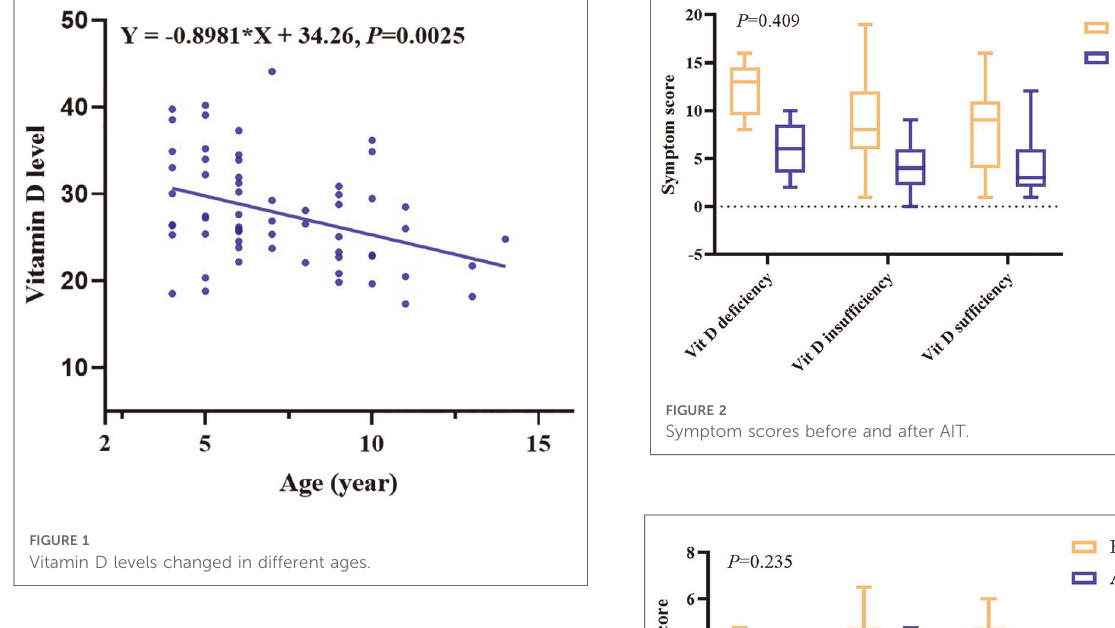
TABLE 2 Symptom score and medication score during the immunotherapy. Groups based on Vit D levels (ng/ml)